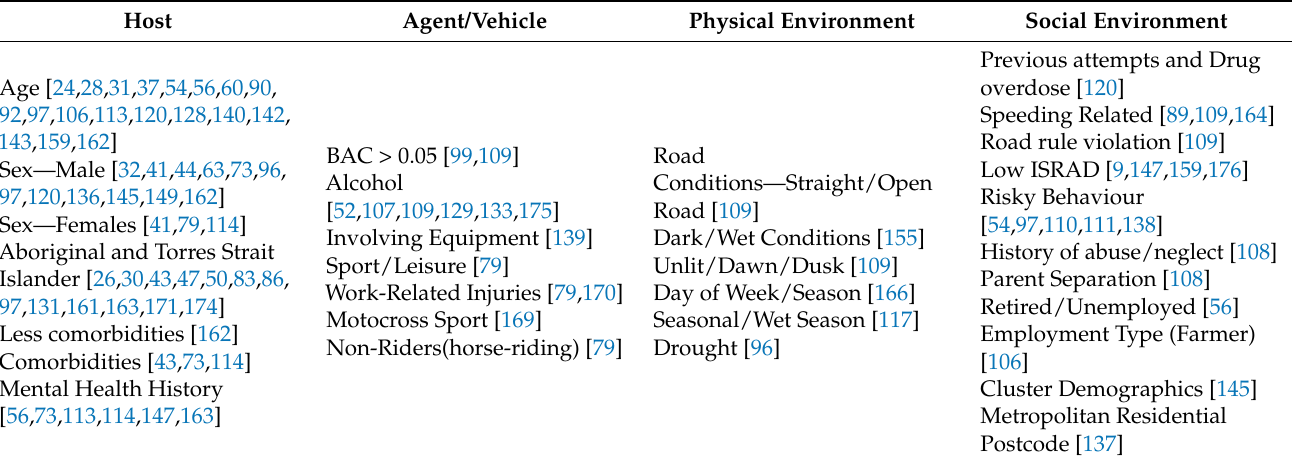
Table 8. Haddon Matrix Factors by Rural Injury Risk